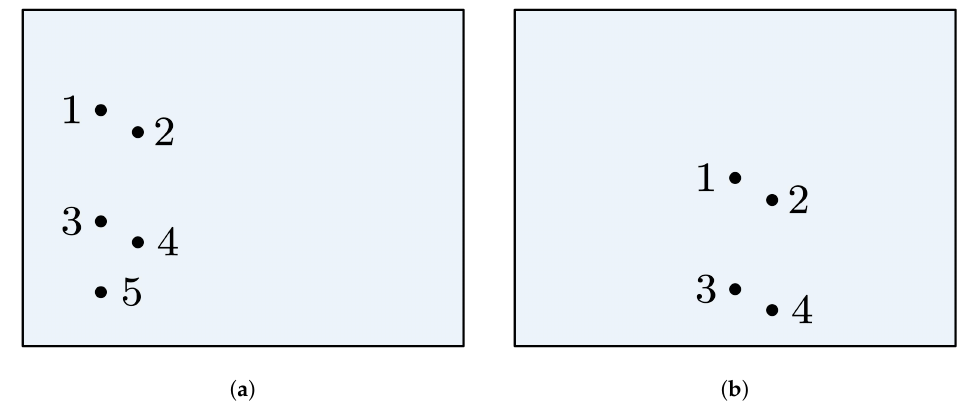
Figure 4. Staring observation for multiple ground targets. ( a ) Initial point distribution. ( b ) Inappro- priate point